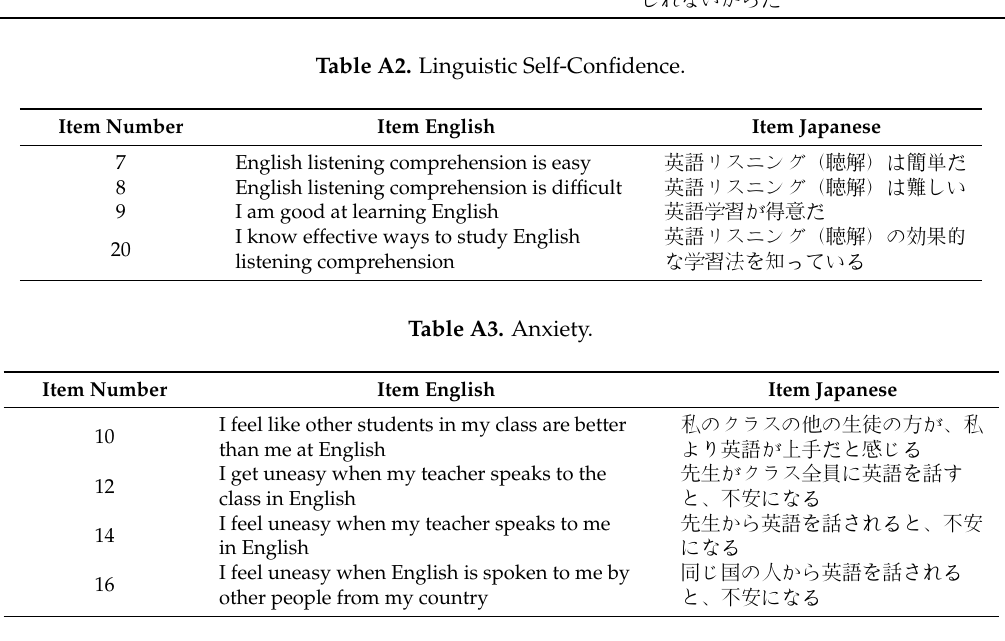
Table A4. Interest in the